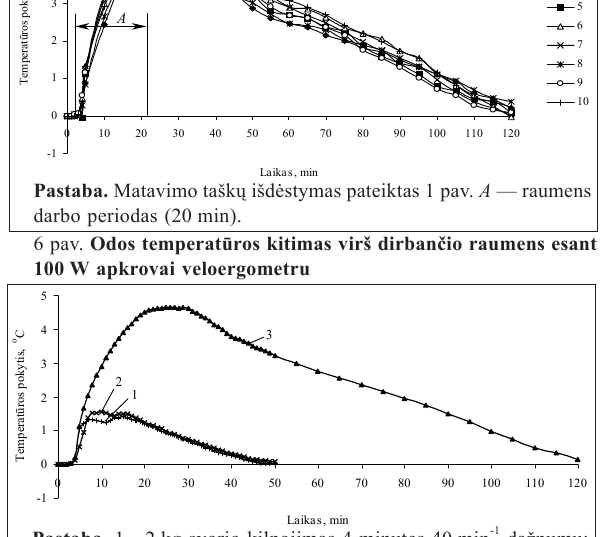
vimo periodo, kuris nutraukiamas po 1 min pa- steb ė jus pirmuosius temperat ū ros poky č ius odos pavir(cid:154)iuje vir(cid:154) dirban č io raumens. Pasibaigus s ą lygi(cid:154)kai nusistov ė jusios temperat ū ros periodui, prasideda temperat ū ros kritimo periodas (5 pav.). Trumpalaik ė s 4 kg 1 min apkrovos metu odos temperat ū ra kyla nedaug (5 pav.). Baigus darb ą , temperat ū ra per 4 min padid ė ja iki 1,25(cid:151)2 o C ir i(cid:154)lieka s ą lygi(cid:154)kai pastovi 8(cid:151)16 min. (cid:138)iuo laiko intervalu kai kuriuose matavimo ta(cid:154)kuose pa- stebimas nedidelis temperat ū ros kritimas (apie 0,2 o C). Raumens au(cid:154)imas ir temperat ū ros kritimas iki pradin ė s reik(cid:154)m ė s trunka 30(cid:151)34 min. Tyrimo veloergometru metu buvo atliekamas ilgalaikis vidutinio sunkumo darbas. Kaip matyti 6 paveiksle, pradiniu apkrovos momentu tempera- t ū ra i(cid:154)lieka artima ramyb ė s b ū senos temperat ū rai. Per penki ų minu č i ų darbo laikotarp į pastebimas staigus temperat ū ros padid ė jimas iki 1,3 o C, 5(cid:151) 10 min temperat ū ros pokytis siekia 2,5(cid:151)3,3 o C, 15(cid:151)20 min (cid:151) temperat ū ra pakyla iki 4,4(cid:151)4,8 o C, o baigus darb ą apie 10 min i(cid:154)lieka stabili. Pradin ė ramyb ė s b ū senos temperat ū ra nusistovi per 90 min nutraukus darb ą . Lyginant tarpusavyje vis ų trij ų apkrov ų metu gautus vidutinius temperat ū ros kitimo d ė sningumus ir temperat ū ros poky č ius (6 pav.) matyti, kad jie tiesiogiai susij ę su apkrovos dyd(cid:158)iu. Aptart ų tyrim ų metu raumens į (cid:154)ilimo temperat ū ros kitimo kreivi ų kilimo kampas yra vienodas, trumpalaik ė s apkrovos metu temperat ū ros kilimas daugiau inerti(cid:154)kas, nes po minut ė s pertraukos raumuo jau nebedirba. Rau- mens au(cid:154)imo procesas vis ų trij ų apkrov ų metu yra vienodo pob ū d(cid:158)io. Tai rodo savo dyd(cid:158)iu artimi kreivi ų nusileidimo kampai (7 pav.).